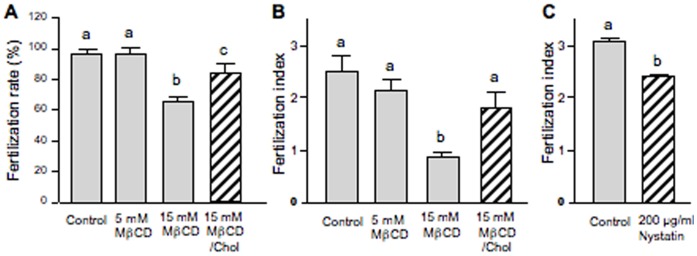
Effect of cholesterol disrupting agents on mouse fertilization.Zona-free mouse oocytes were incubated with either different concentrations of MβCD for 30 min at 37°C to remove cellular cholesterol or 200 µg/ml of Nystatin to sequestrate cholesterol into complexes. Cholesterol repletion was carried out incubating MβCD-treated oocytes with MβCD/Chol complexes. After depletion/repletion and sequestration treatments, oocytes were washed and inseminated. (A) Effect of cholesterol depletion and repletion on the fertilization rateand (B) fertilization index. (C) Effect of Nystatin induced cholesterol sequestration on the fertilization index. Data in A and B represent the mean ± SEM of at least 3 independent experiments from a total of 101 control oocytes, 49 oocytes depleted at 5 mM, 92 oocytes depleted at 15 mM and 52 oocytes depleted/repleted at 15 mM of MβCD. Data in C represent the mean ± SEM of 3 independent experiments from a total of 33 control oocytes and 72 Nystatin-treated oocytes. Comparison of mean values was performed using LSD or Student’s t tests. Different letters (a-c) denote significant differences (P<0.05).